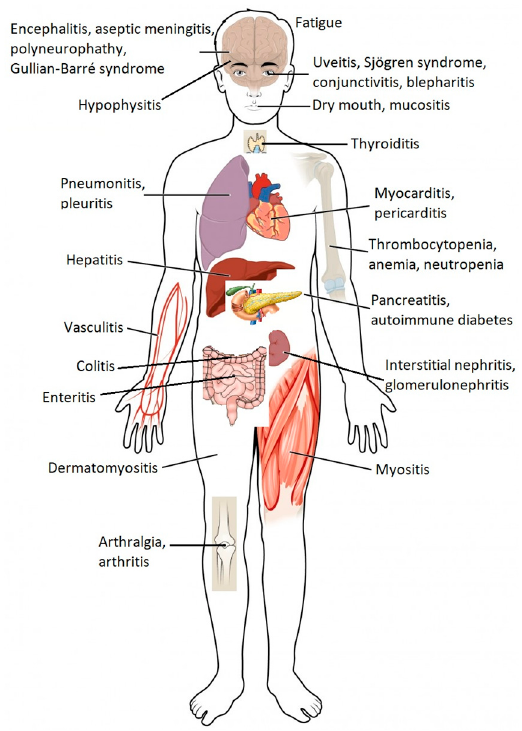
Figure 2. Common immune-related adverse events associated with immune checkpoint blockade by organs of the human body. Immune checkpoint blockade can result in the inflammation of any organ (adapted from ref. [1] and [6]) .